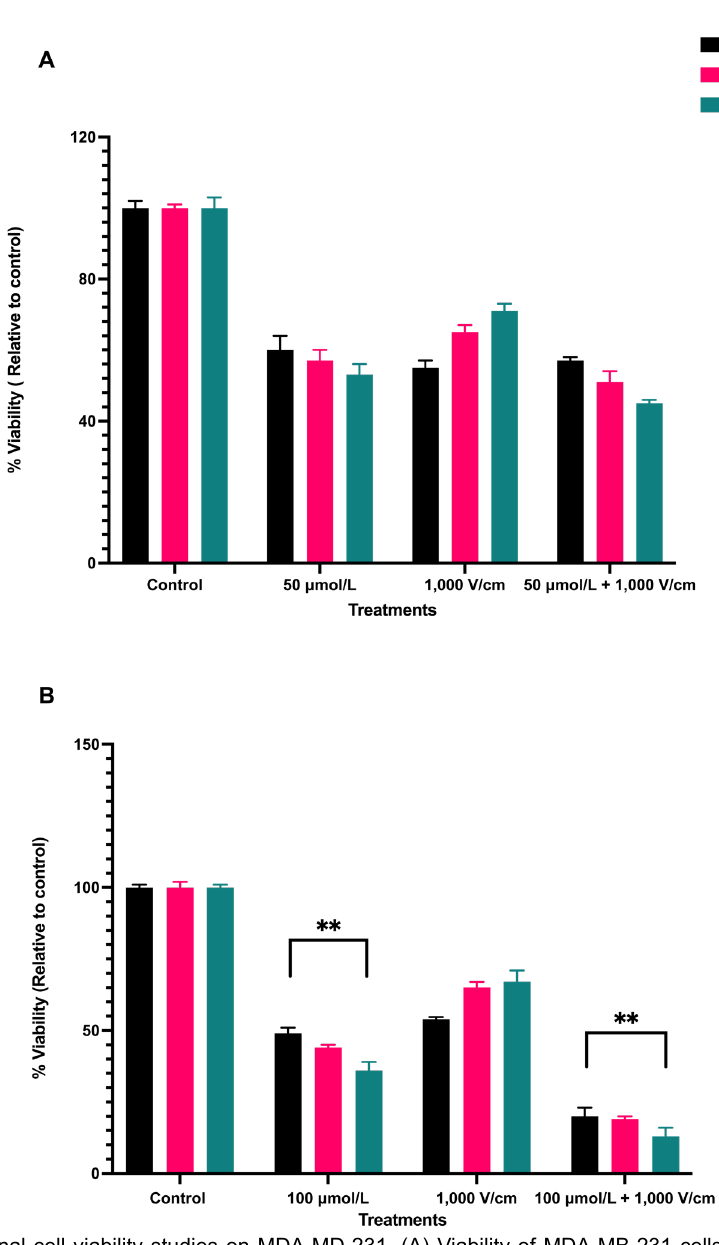
Figure 4. Combinational cell viability studies on MDA-MD-231. (A) Viability of MDA-MB-231 cells with 50 μmol/L RESV along with 1,000 V/cm compared to control and drug only treatments; (B) viability of MDA-MB-231 cells at 100 μmol/L + 1,000 V/cm compared with drug only and control. indicates the significant differences ( P < **